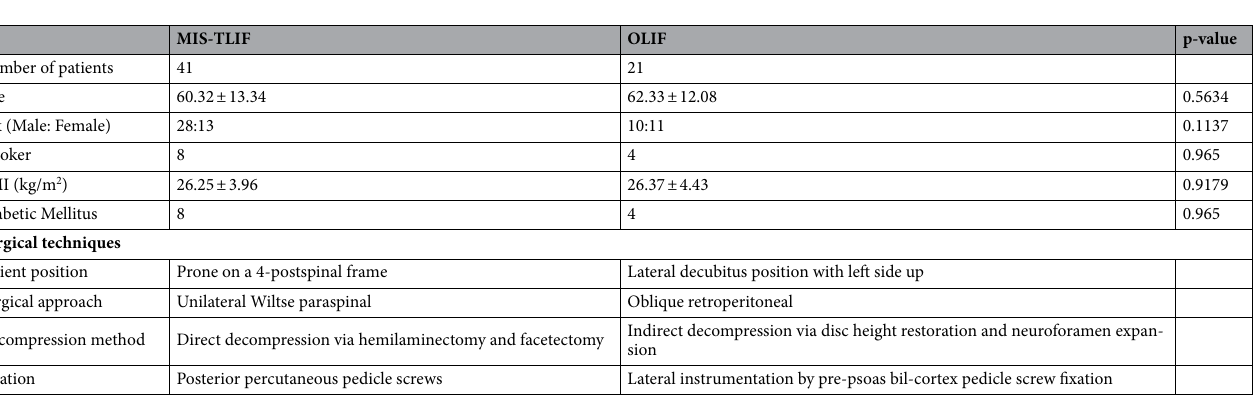
Table 1. Demographic parameters and the comparisons of the two surgical techniques. Values are mean ± standard deviation; OLIF: oblique lateral lumbar interbody fusion; MI-TLIF: minimally